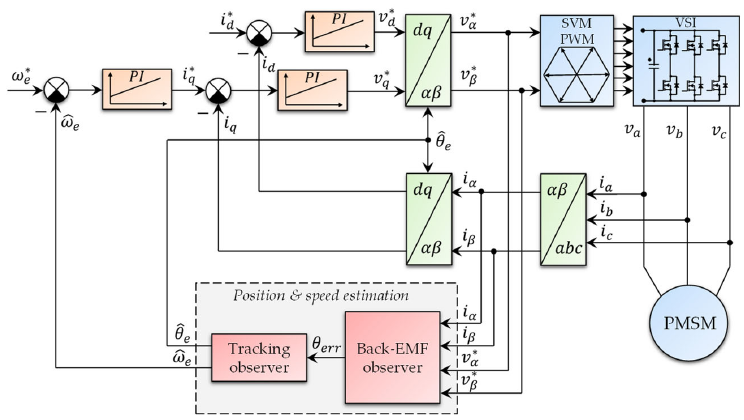
Figure 3. Block diagram of the sensorless FOC with the Luenberger-type back-EMF observer and tracking observer.